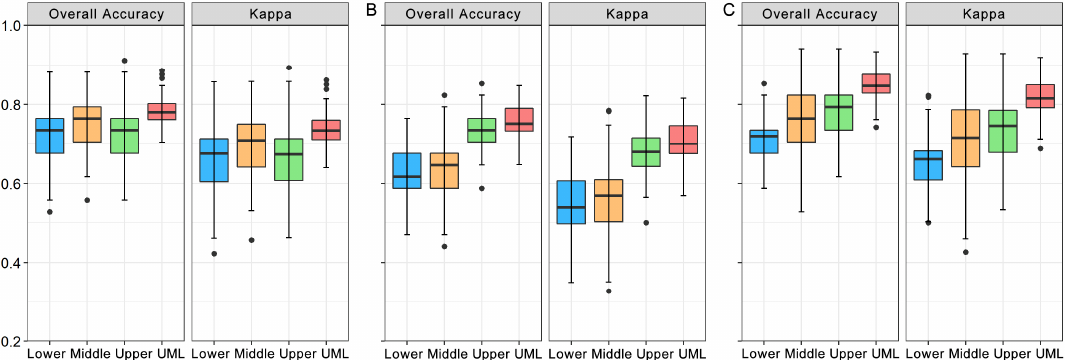
Figure 6. Variation of OA and Kappa in different canopy layers based on ( A ) the LFT dataset, ( B ) LHR dataset and ( C ) LFT + LHR dataset. The UML is the pooled data of the upper, middle and lower layers.